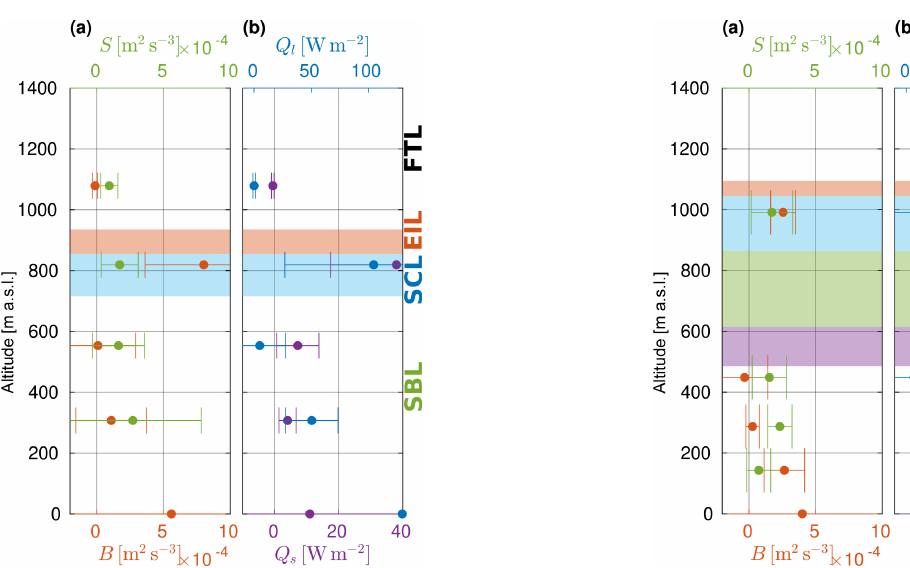
Figure 11. (a) TKE production by buoyancy B and shear S , (b) sen- sible Q s and latent Q l heat fluxes in the coupled STBL (flight no. 5). The lowest dot denotes the parameterized surface value obtained with the COARE 3.0 algorithm.